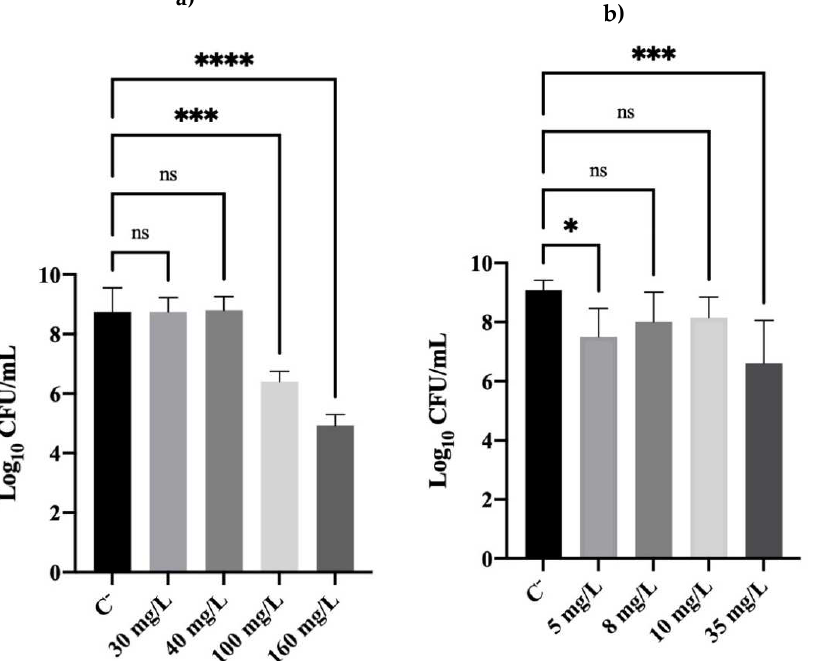
Figure 1. Logarithm of the CFUs/mL of Pseudomonas fluorescens cells after an overnight step in a nutrient medium. Cells had been previously exposed to different concentrations of ( a ) BAC and ( b ) DBNPA for 30 min. Controls were performed with untreated cells (C − ). The means ± standard deviation of three independent experiments are presented. ‘ns’ indicates not significant ( p > 0.05), whereas the asterisks indicate statistical significance (* p < 0.05; *** p < 0.001; and **** p < 0.0001), using Tukey’s multiple comparison test.